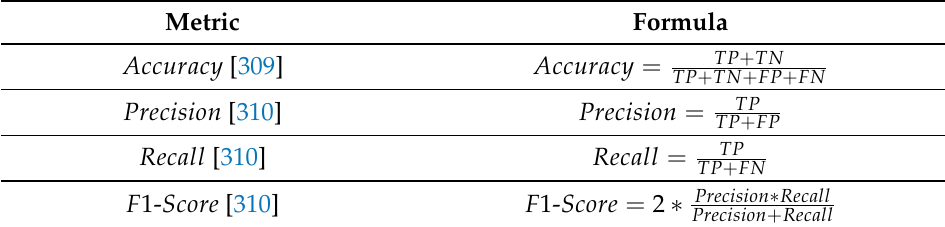
Table 5. List of TC evaluation metrics formulations, where true positive ( TP ), true negative ( TN ), false positive ( FP ), and false negative ( FN ) represent the number of predicted